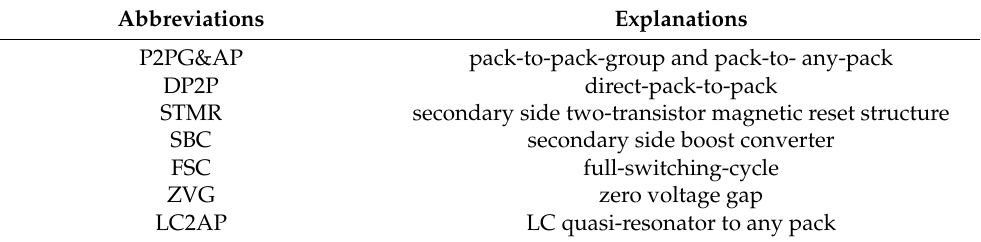
Table 1. The abbreviations and explanations of all the special nouns.